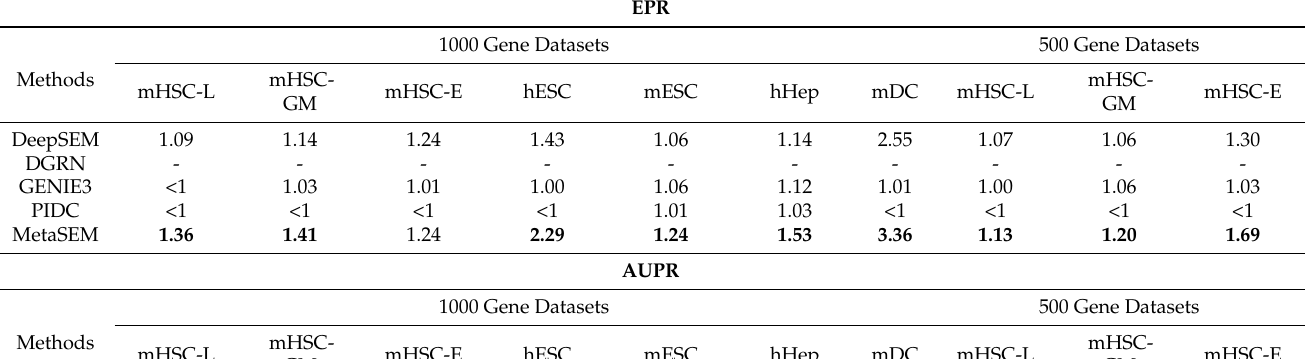
Table 1. Performance comparison of four competing methods on 1000 gene datasets and 500 gene datasets.